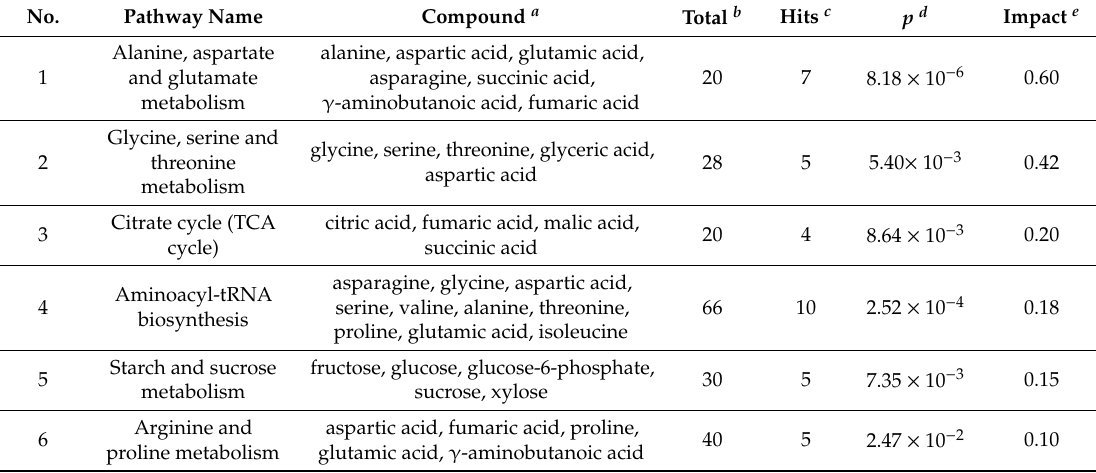
Table 4. Main metabolic pathways activated in the fermented and non-fermented VJs.